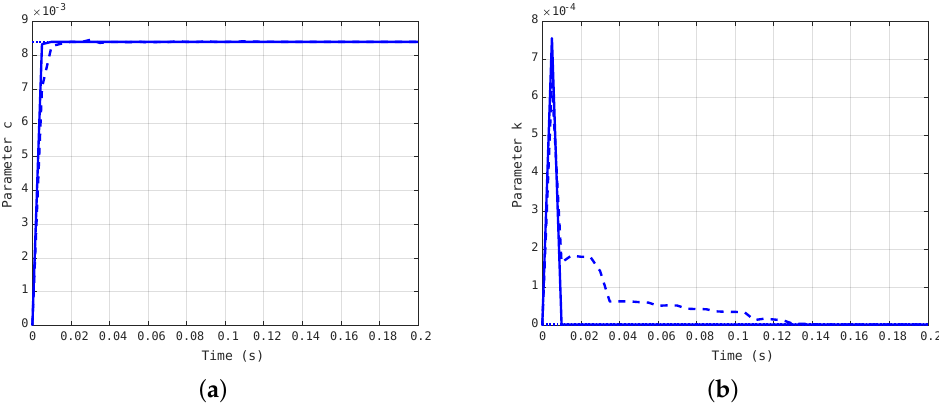
Figure 5. Time evolution of the estimated parameters c ( a ) and k ( b ) for the second case: c = 8.4 × 10 − 3 Nms/rad, k = 2.5 × 10 − 6